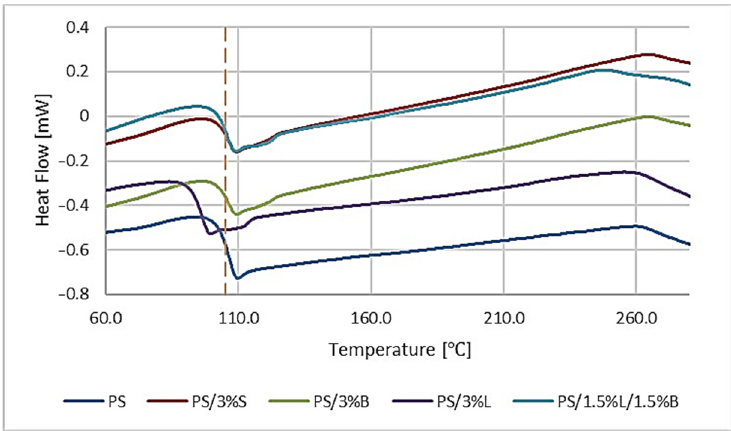
Figure 8. Results of the differential scanning calorimetry (DSC) analysis of PS and PS composites.